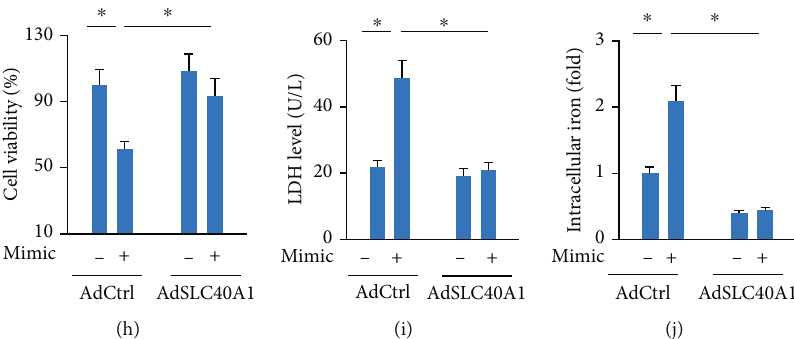
Figure 4: The miR-147a mimic elicits ferroptosis of human glioblastoma cells through targeting SLC40A1. (a) Sequence alignment of miR- 147a and the 3 ′ -UTR of SLC40A1. (b) SLC40A1 protein level in human glioblastoma tissues and normal brain tissues. (c – e) The mRNA and protein levels of SLC40A1 in cells treated with or without the miR-147a mimic. (f) Relative luciferase activity. (g) The mRNA level SLC40A1 in cells infected with or without AdSCL40A1. (h) Cell viability detected by CCK-8 assay. (i) LDH level in the medium from the miR-147a mimic-treated cells with or without SLC40A1 overexpression. (j) Relative level of intracellular iron. N = 6 for each group. Data were expressed as the mean ± SD , and P < 0 : 05 was considered statistically signi fi cant. NS indicates no signi fi cance.